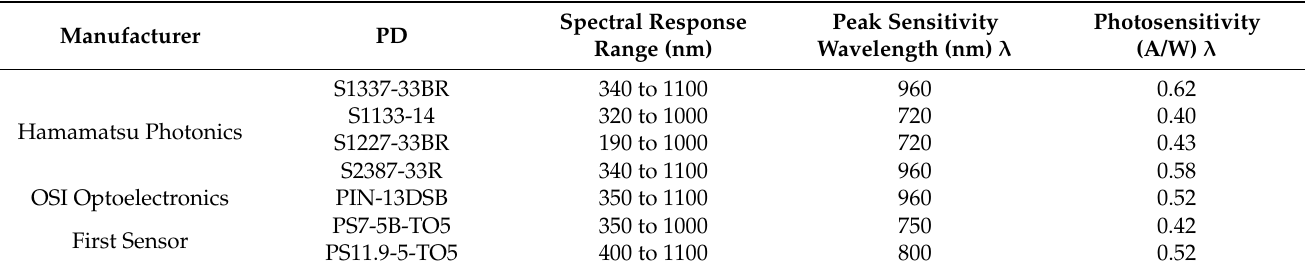
Table 1. Alternative PDs and optical